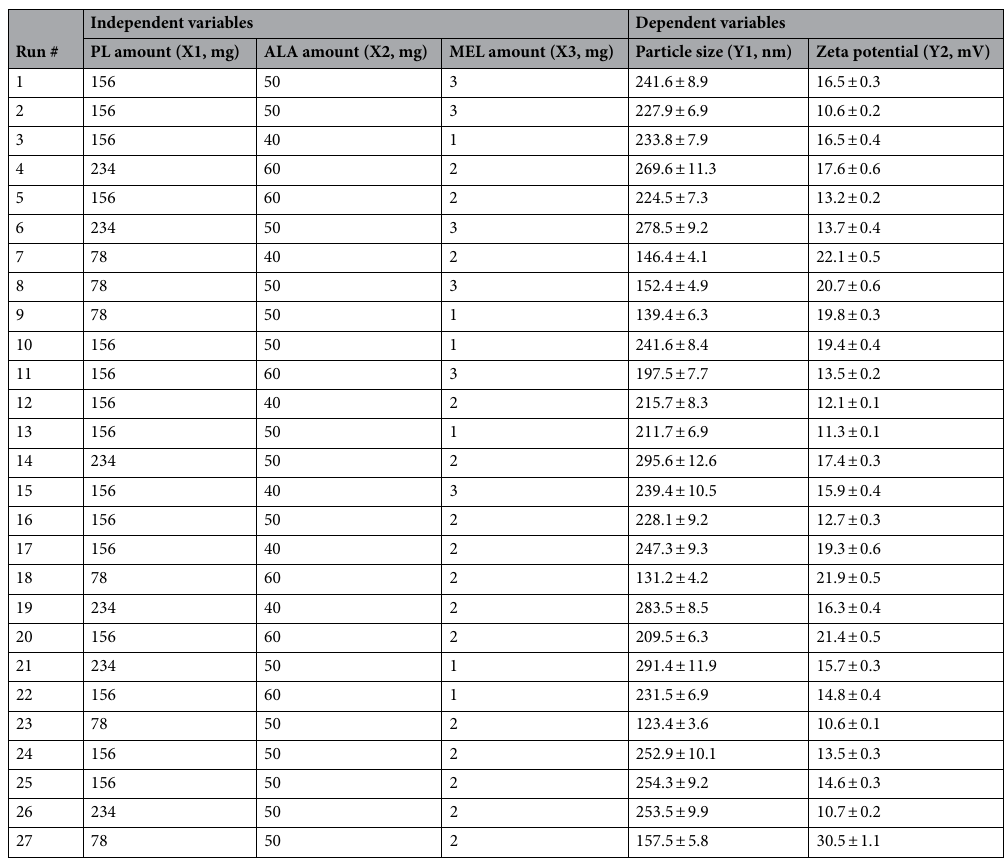
Table 2. Combination of variables’ levels in FLV- PL-ALA-MEL nanoformula and their measured